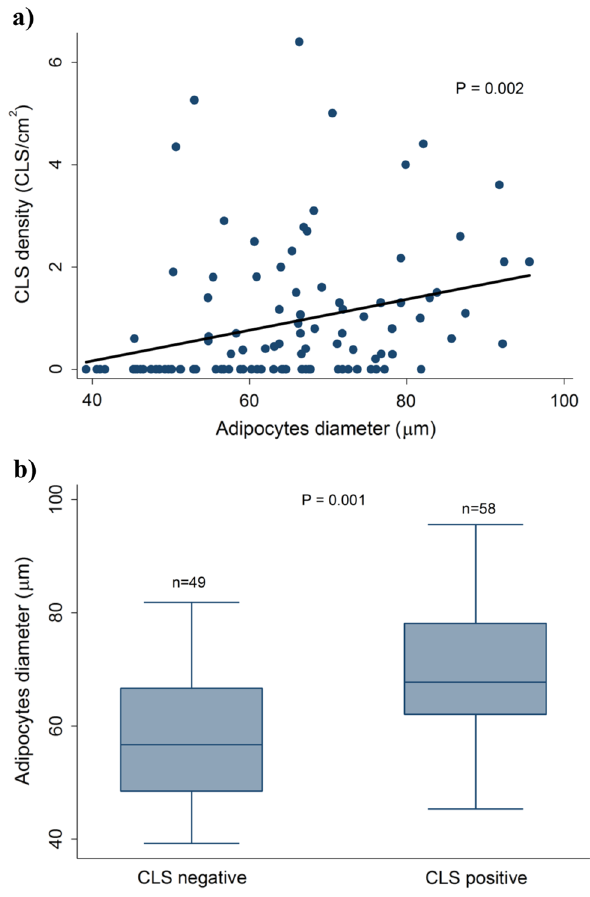
Fig. 3 Existence of a relationship between CLS density and adipocyte size. a Scatter plot and linear relationship of CLS density and adipocyte diameter. The P -value is obtained from a test of no linear association. b Box plot that shows the distribution